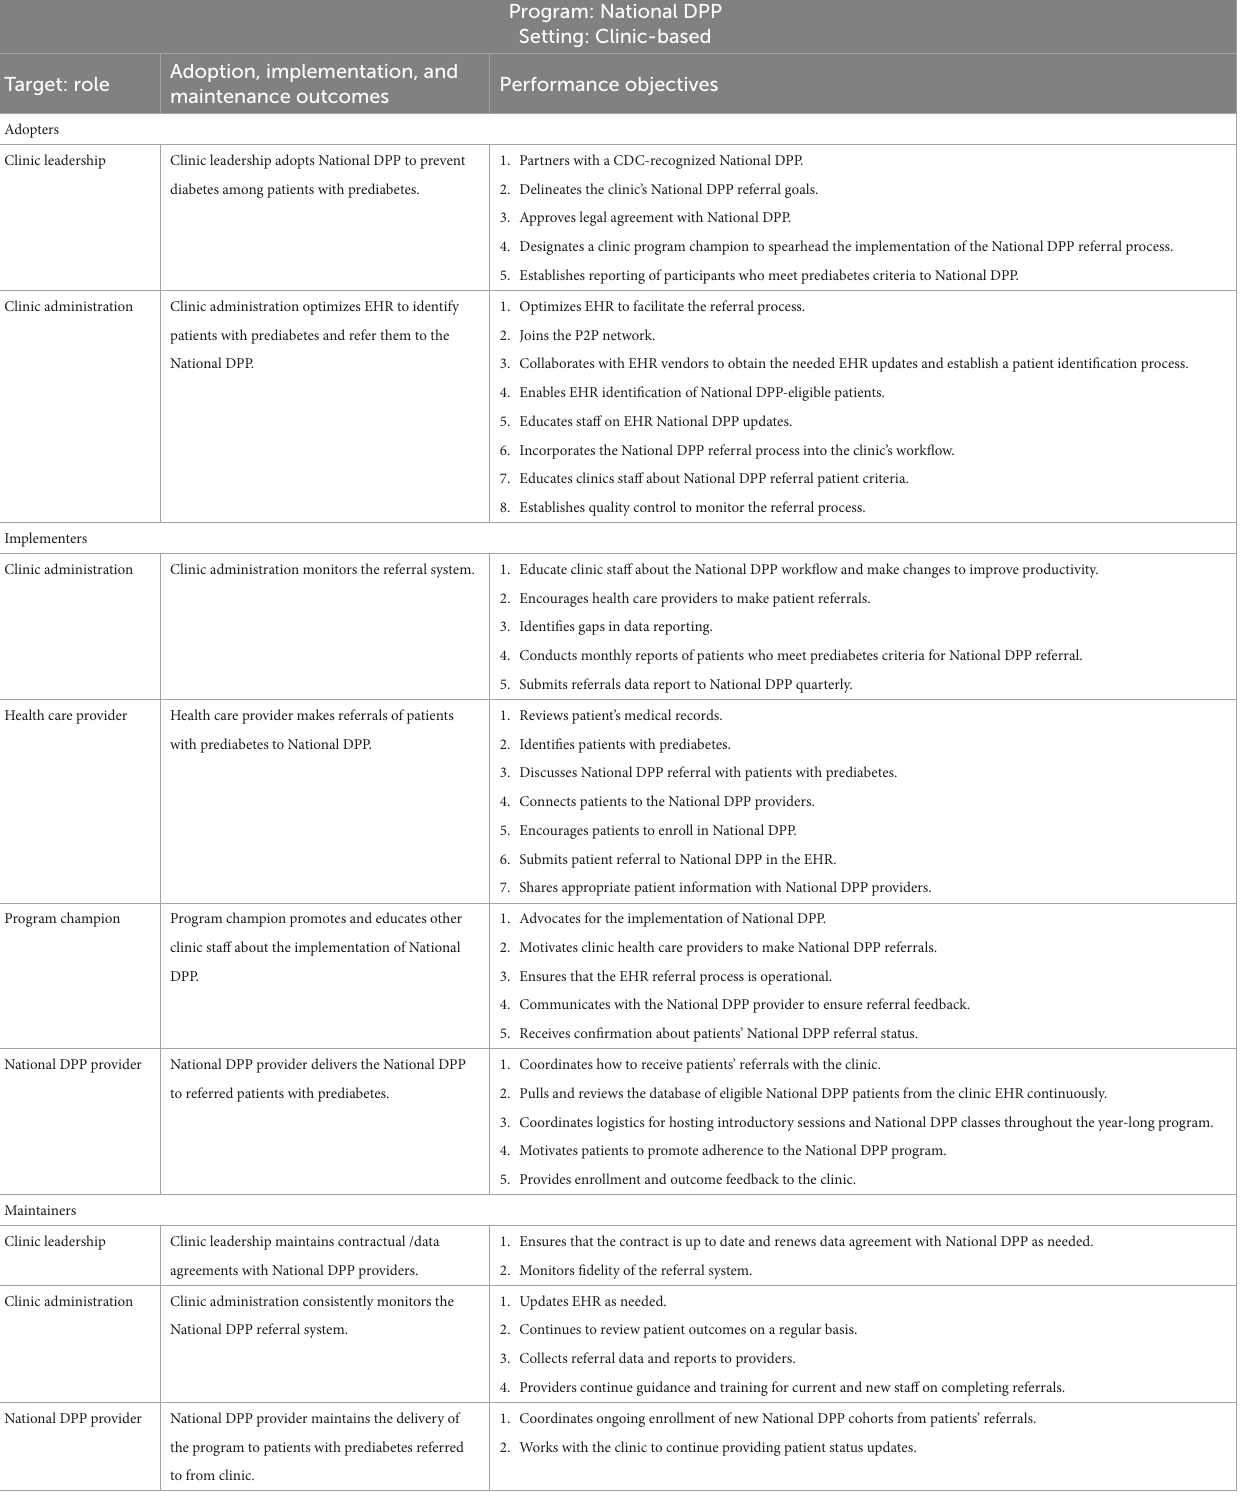
TABLE 2 Sample adoption, implementation, and maintenance outcomes and performance